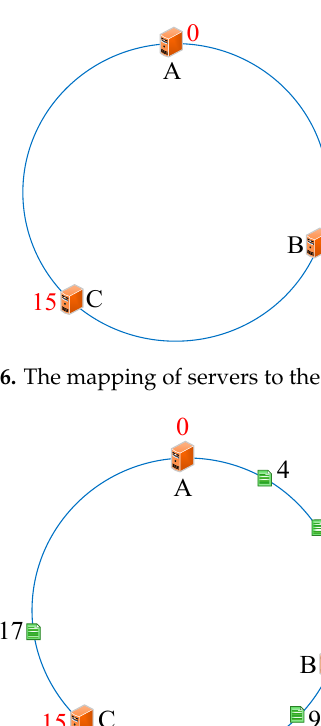
Figure 5. The designed hash circle.